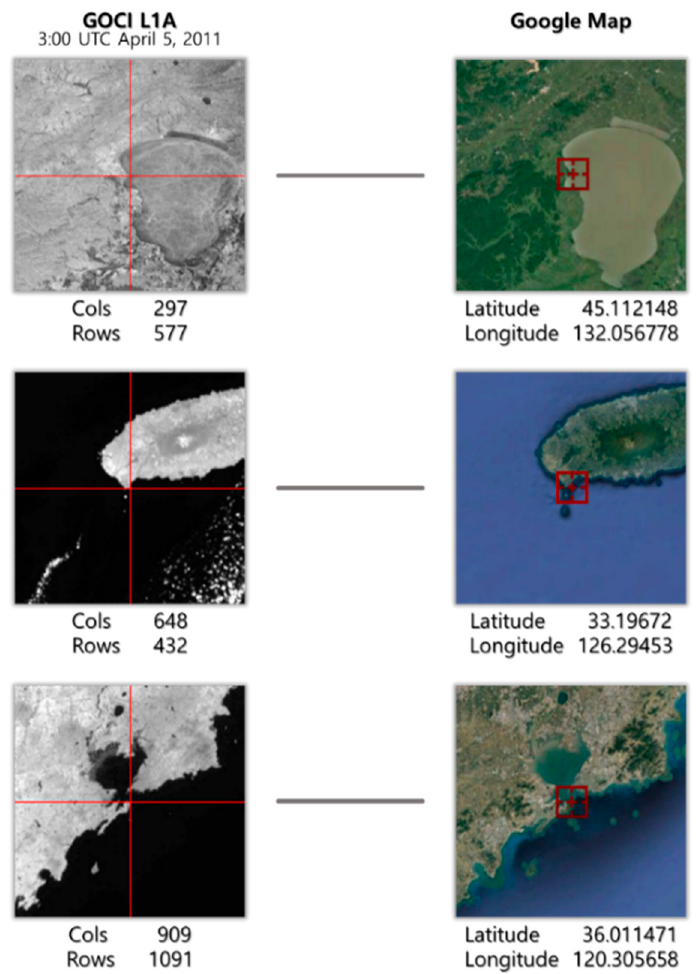
Figure 12. Examples of validation GCPs and the corresponding parts of GOCI slots.